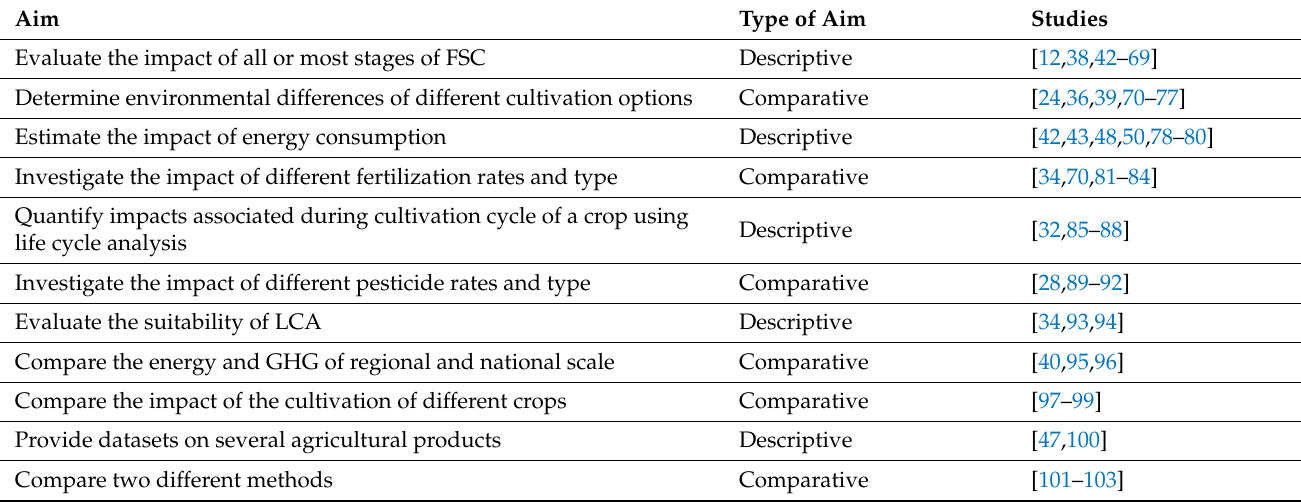
Table A1. Common aims in the selected